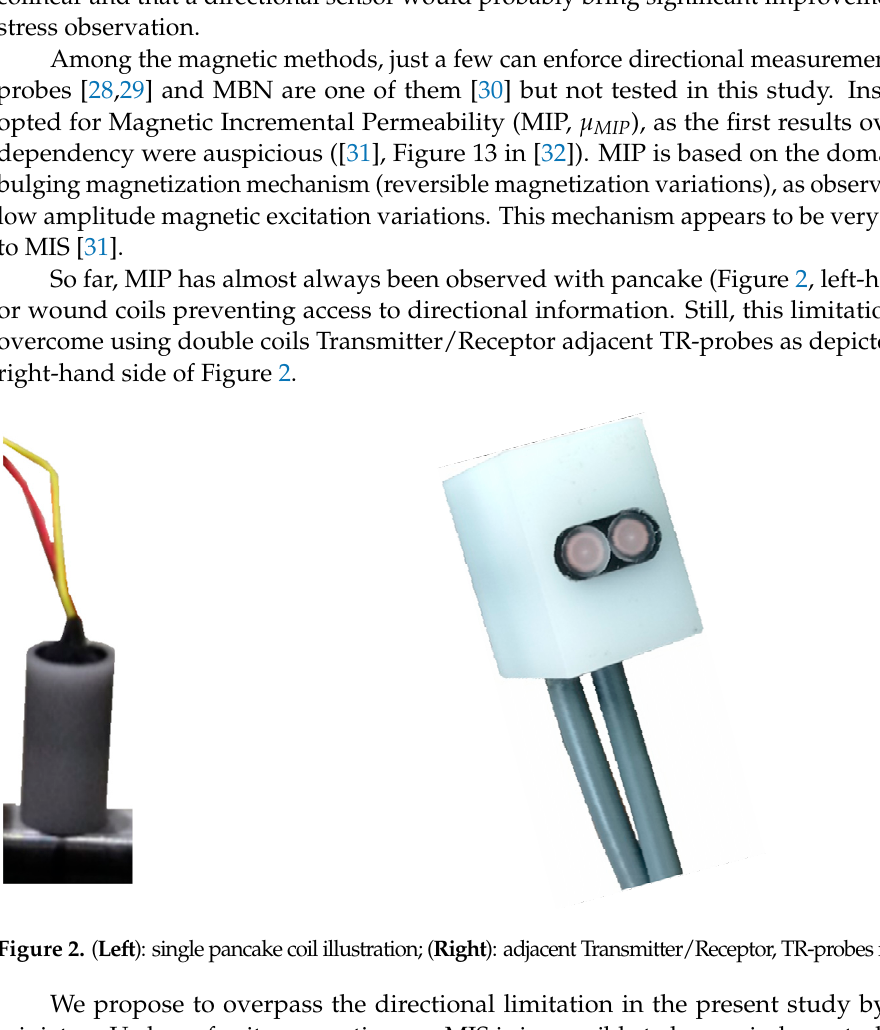
Figure 2. ( Left ): single pancake coil illustration; ( Right ): adjacent Transmitter/Receptor, TR ‐ probes illustration.